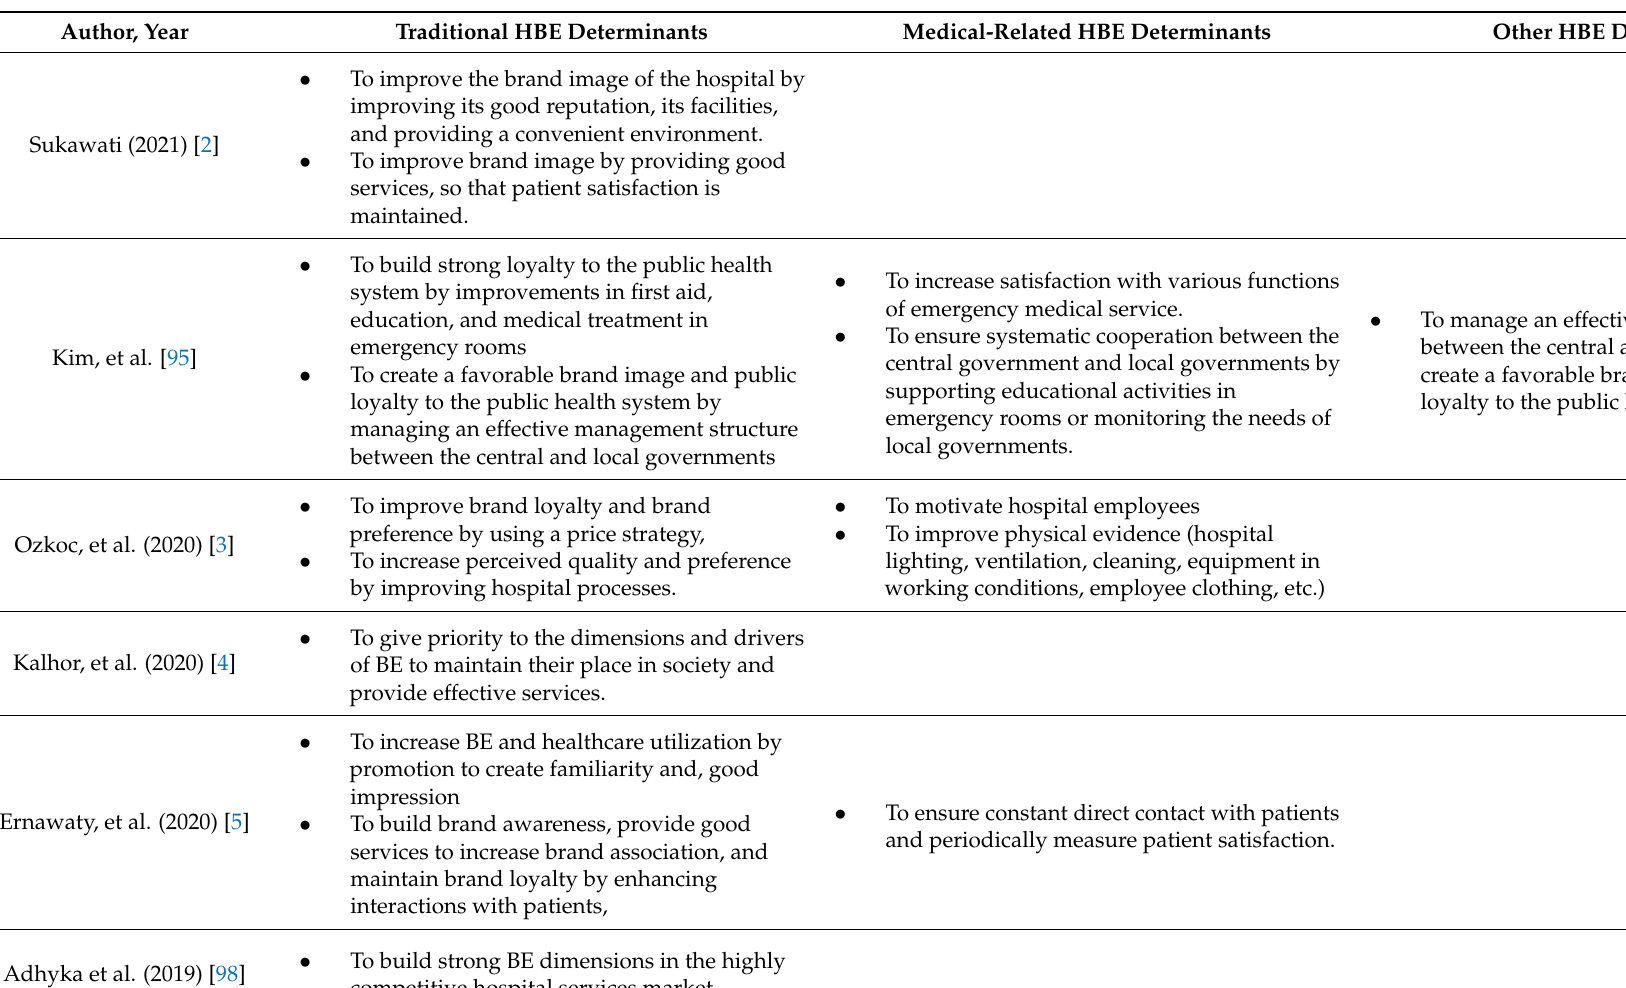
Table 5. Practical implications by groups of HBE determinants for the studies included in the systematic